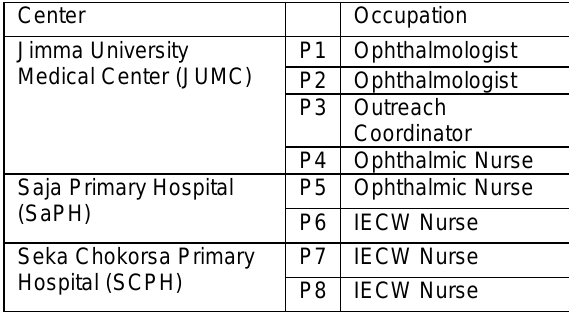
Table 1 . Overview of participants in the semi- structured